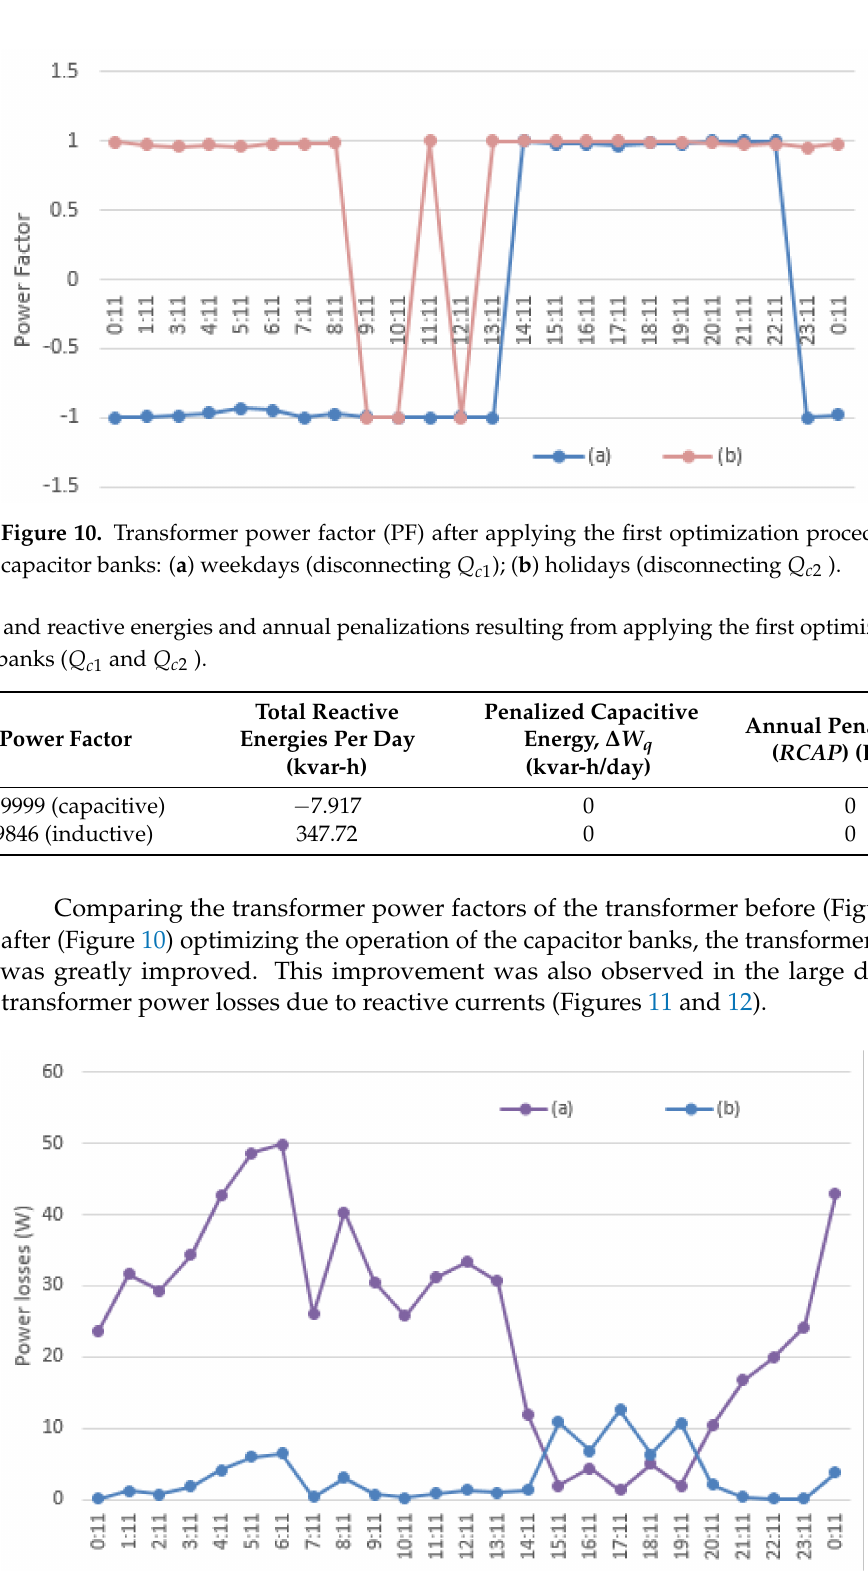
Figure 11. Transformer power losses, on weekdays, due to: ( a ) actual reactive currents with non- optimized capacitors; and ( b ) reactive currents with capacitor banks